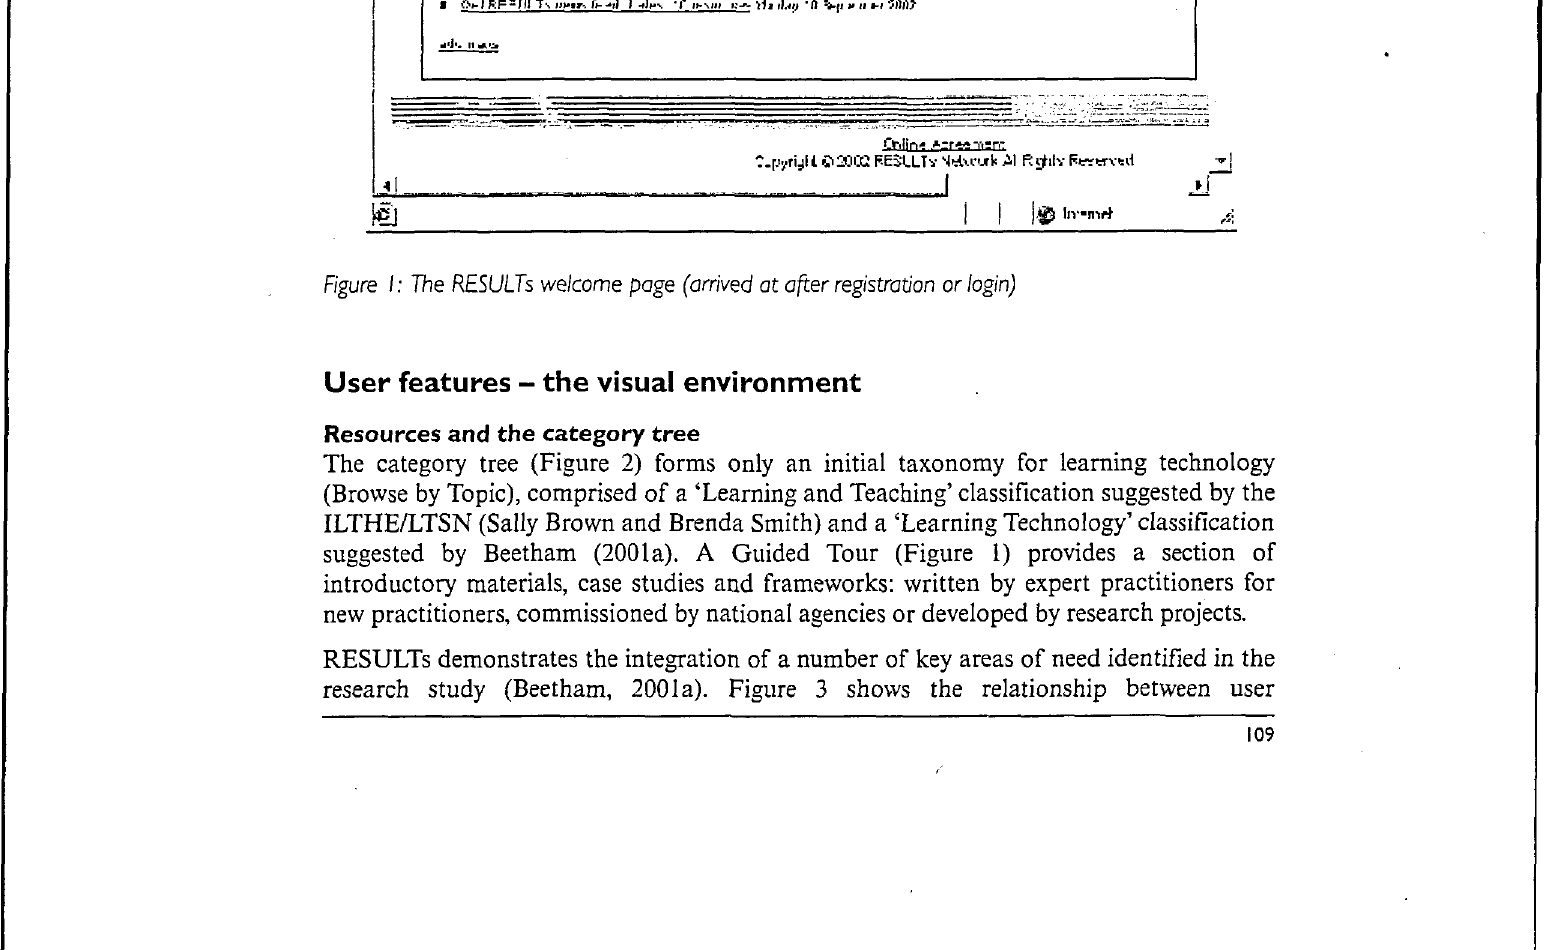
Figure I: The RESULTs welcome page (arrived at after registration or login)